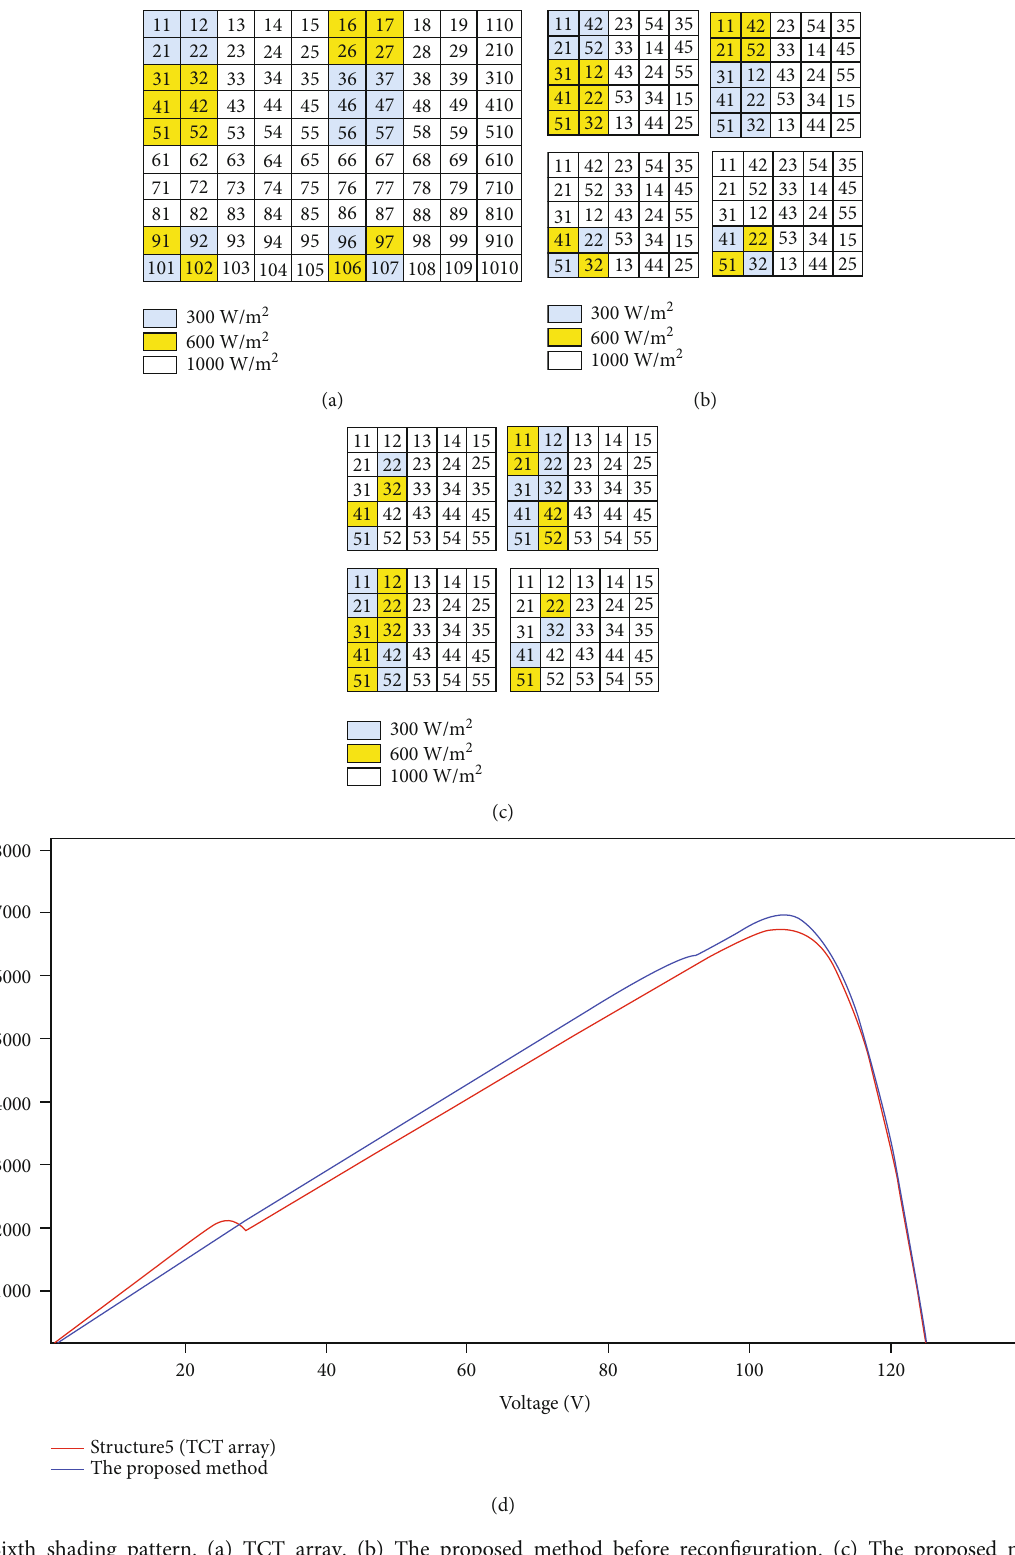
Figure 15: Sixth shading pattern. (a) TCT array. (b) The proposed method before recon fi guration. (c) The proposed method after recon fi guration. (d) The PV array characteristics for the TCT array and the proposed